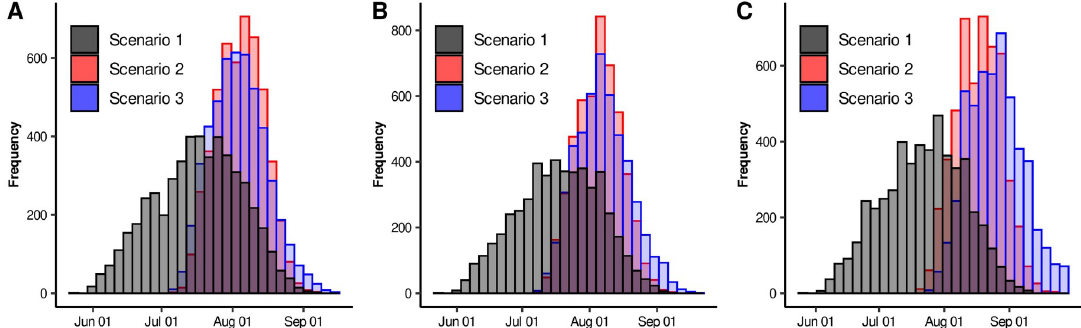
Fig 5. Histograms of acme dates for different epidemic curves. Black, red and blue bars are related to Scenarios 1, 2, and 3, respectively. A) acme of daily new reported cases. B) acme of daily hospitalizations. C) acme of daily deaths.